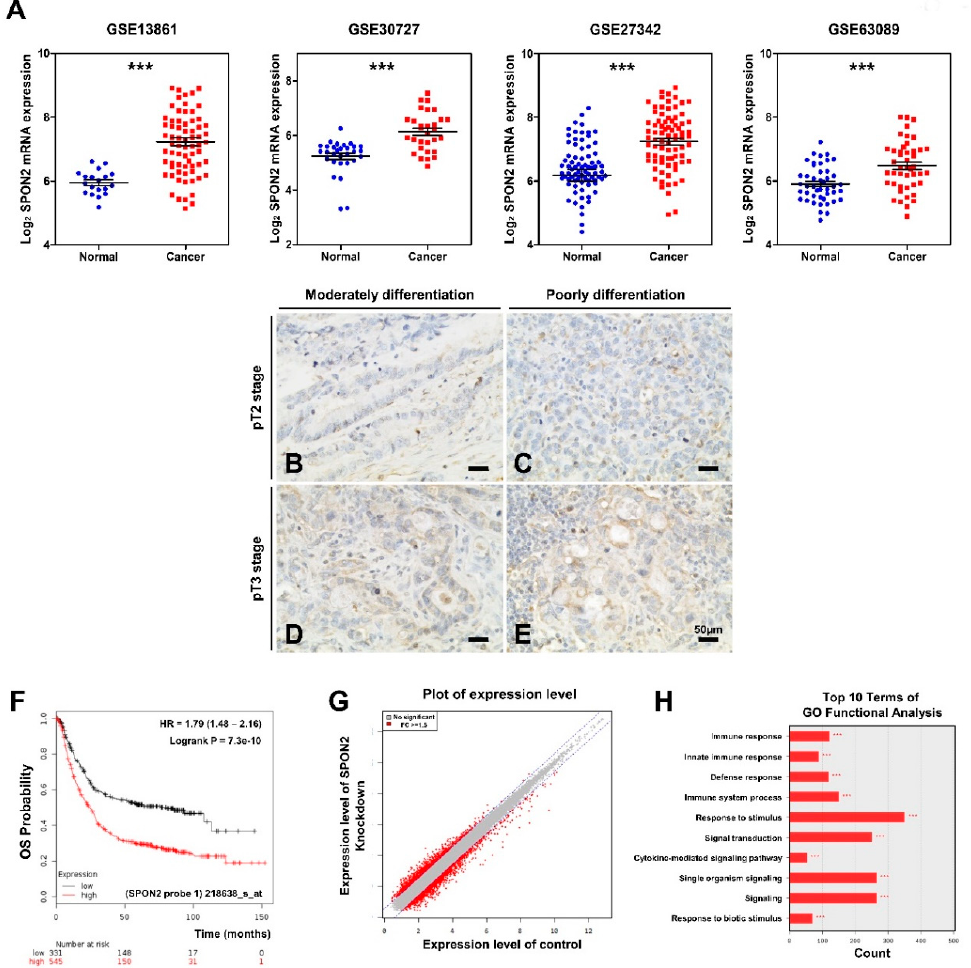
Figure 1. Spondin-2 upregulates in patients with gastric cancer and is associated with poor prognosis. ( A ) Detection of spondin-2 ( SPON2 ) mRNA expression levels in patients with gastric cancer using Gene Expression Omnibus (GEO) database. Four datasets were used: GSE13861 ( n = 90), GSE30727 ( n = 60), GSE27342 ( n = 160), and GSE63089 ( n = 90). ( B – E ) Representative photomicrographs showing SPON2 expression in gastric cancer tissue microarray (TMA) ( n = 72). SPON2 expression was observed to be either very weak / no expression ( B and C ), or more than moderate expression ( D and E ) in tumor cells. ( × 400 magnification). ( F ) Kaplan–Meier overall survival (OS) plot analysis of public database indicates an association between SPON2 expression level and poor survival rates of patients with gastric cancer. ( G , H ) Gene expressions were analyzed by cDNA microarray in SPON2-silenced MKN28 cells. ( G ) Plot shows di ff erentially expressed genes (red dot = FC > 1.5, grey dot = FC < 1.5). ( H ) GO terms of biological process related to genes for FC > 1.5. p -values were calculated using Student’s t -test, and significant di ff erences are indicated by * (*** p < 0.001).